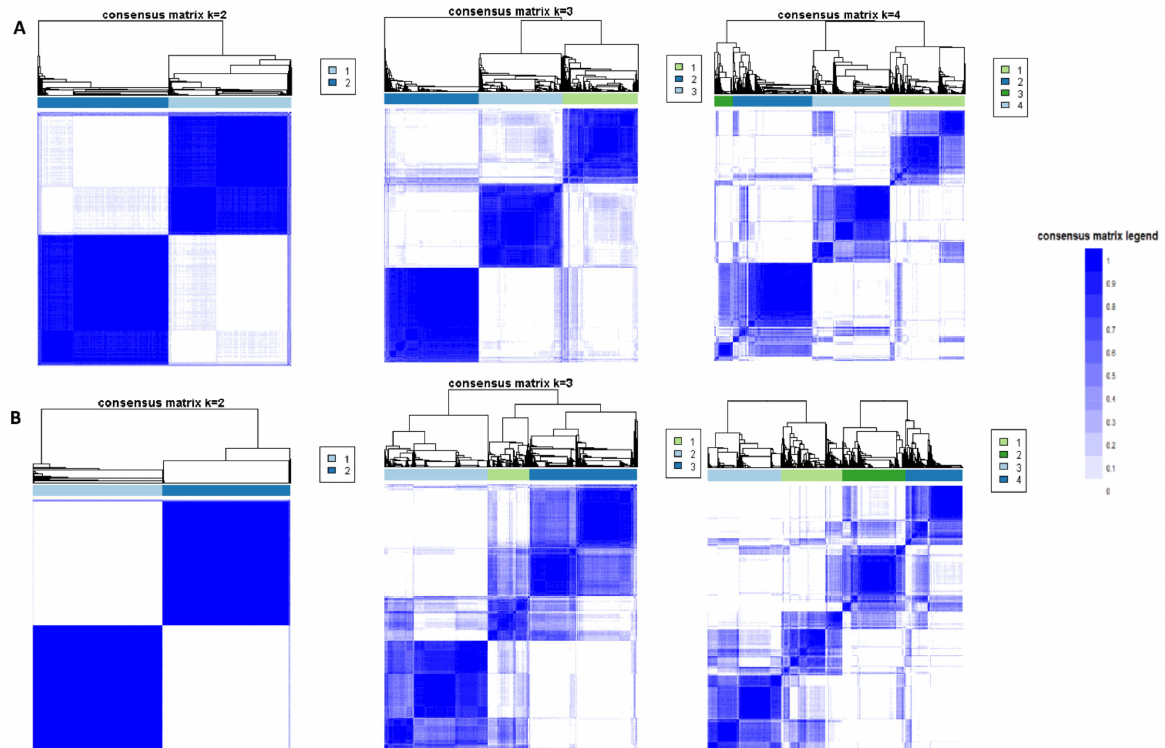
Figure 1. ( A ) Consensus matrix heat map displaying consensus values on a white to blue color scale for each cluster of patients with hypophosphatemia; ( B ) Consensus matrix heat map displaying consensus values on a white to blue color scale for each cluster of patients with hyperphosphatemia.